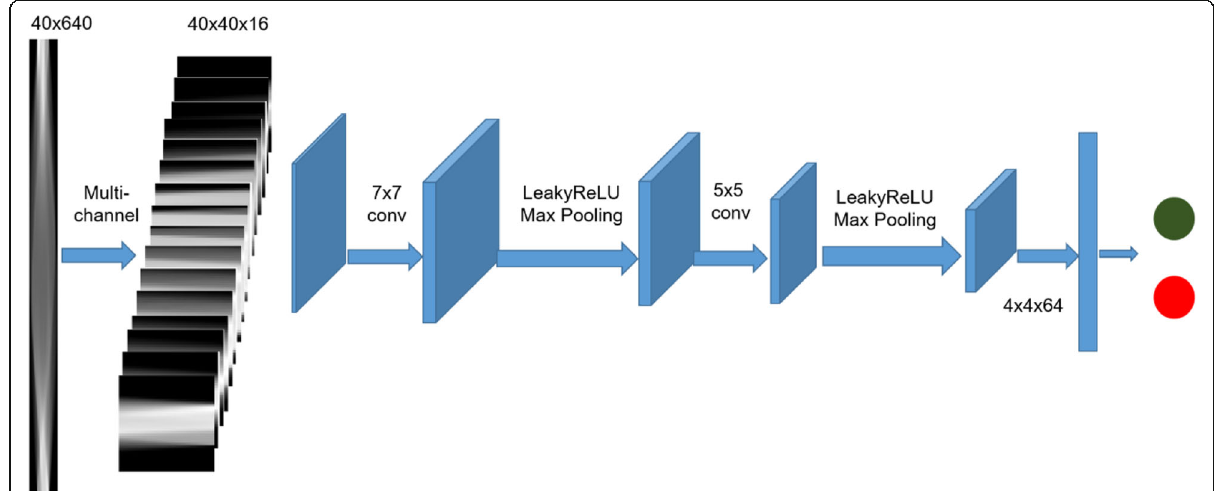
Fig. 3 General workflow of our proposed sinogram based nodule detection method. The network contains 2 convolution layers with kernel sizes 7 × 7 and 5 × 5, with max-pooling layers following each convolution. Softmax is used as the final layer for generating risk